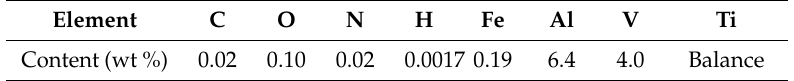
Table 1. Chemical composition of the powder used in this research (by weight percent).